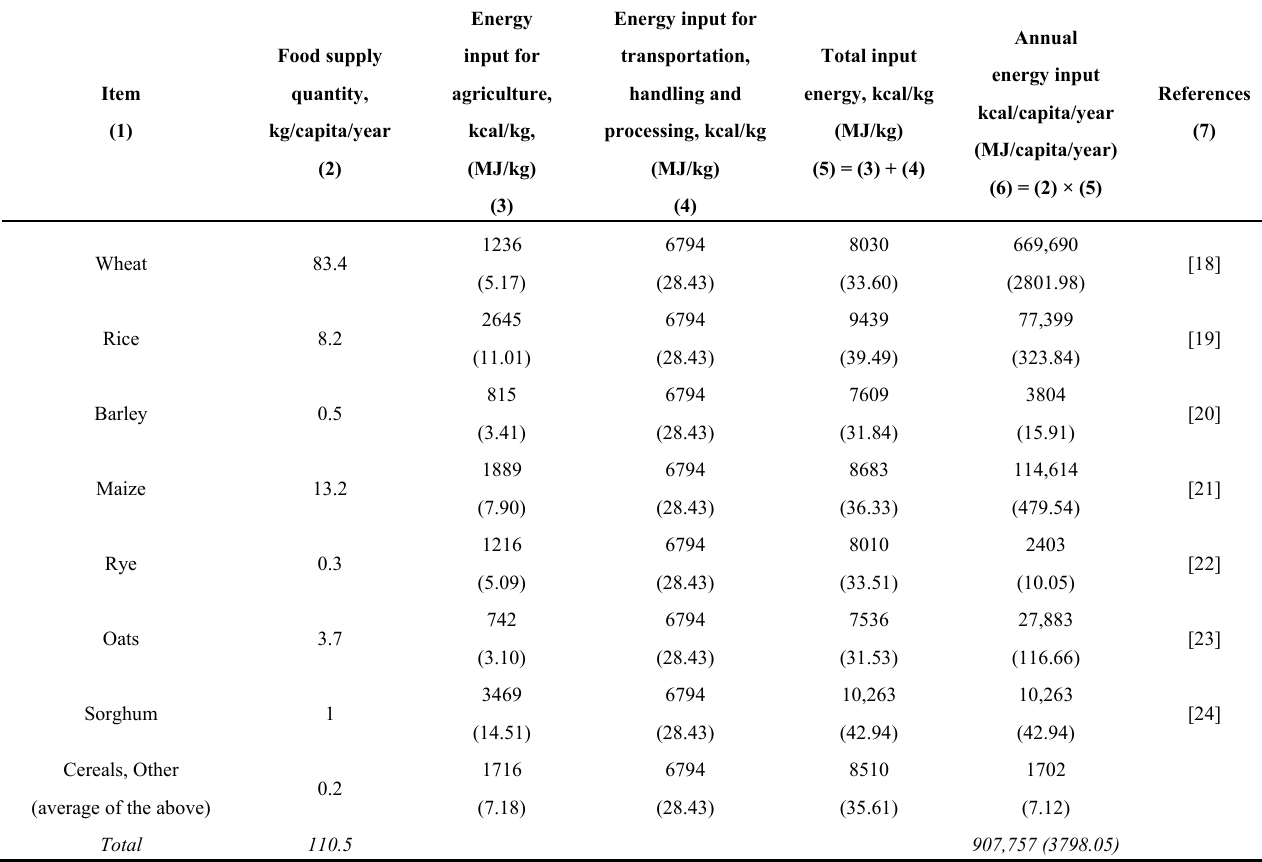
Table 3. Grain food supply for the year 2004